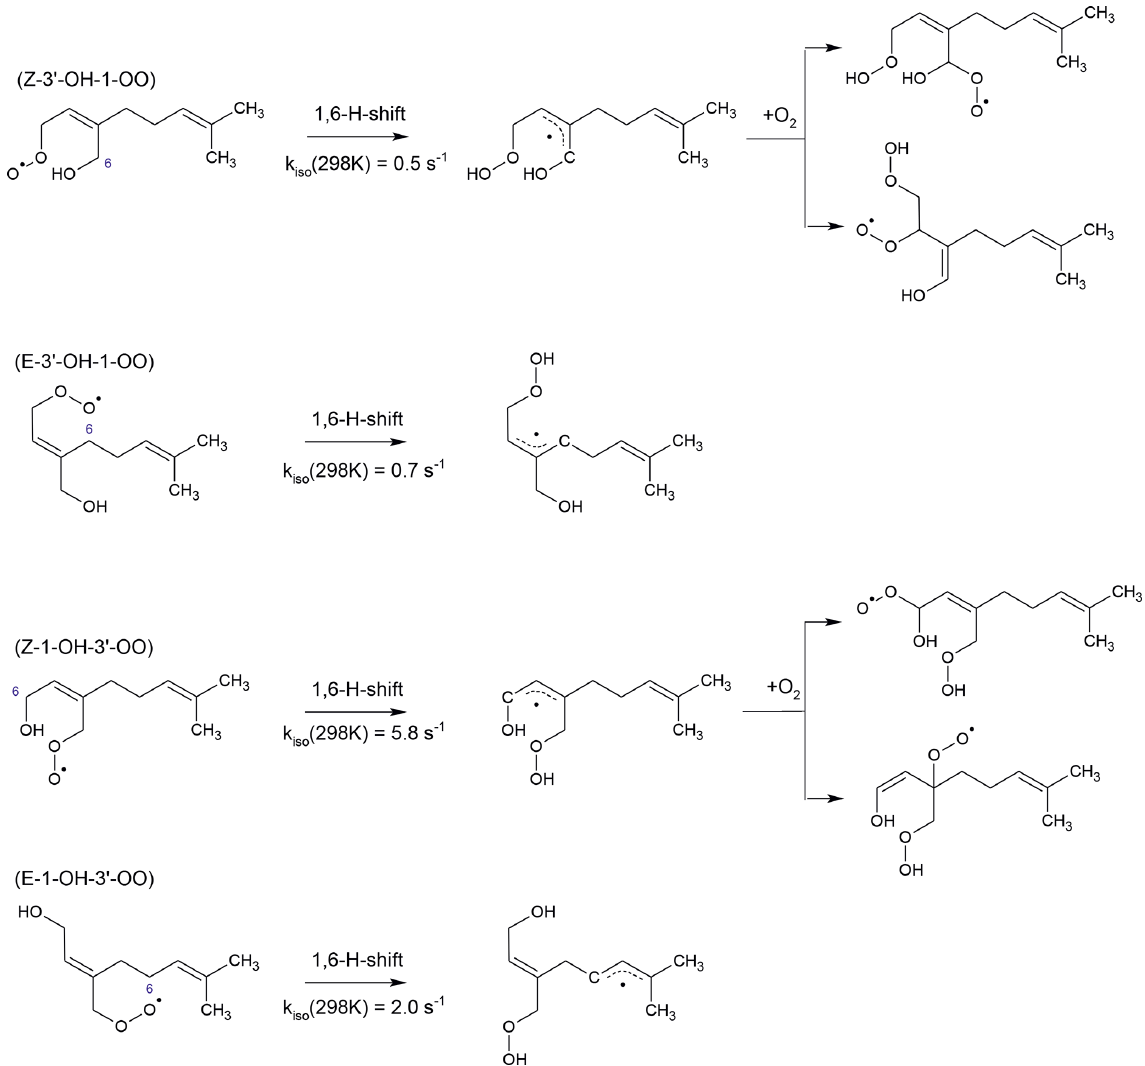
Figure 4. Fast H-shift reactions of myrcene peroxy radicals. Rate constants apply to 298K. They are adopted for the Z − 3 (cid:48) − OH − 1 − OO and Z − 1 − OH − 3 (cid:48) − OO isomers from the corresponding 1,6-H-shift reactions of isoprene peroxy radicals (Peeters et al., 2014). Similar subsequent chemistry like for isoprene leads to the formation of peroxy radicals, some of which rapidly decompose. The isomerization reaction rate constants for the E − 3 (cid:48) − OH − 1 − OO and E − 1 − OH − 3 (cid:48) − OO peroxy radicals are calculated using SAR by Vereecken and Nozière (2020). Subsequent chemistry of products from these reactions likely undergoes fast ring-closure reactions on the dimethyl double bond (not shown here). Table 1. Experimental conditions for the oxidation experiments. Concentrations are given for the conditions in the SAPHIR chamber at the time of the first VOC